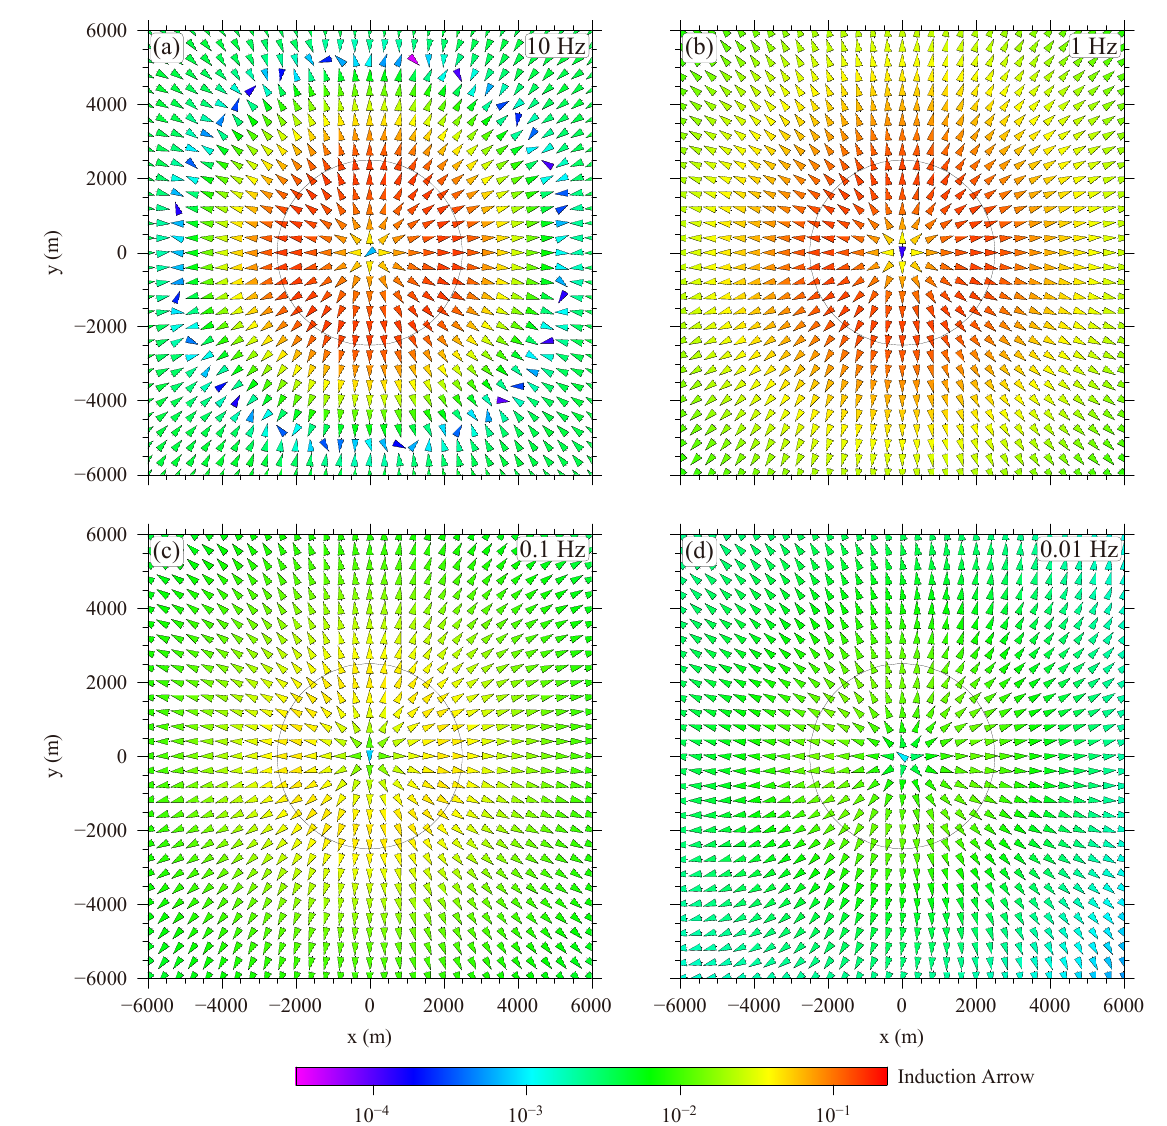
Figure 8. The vector maps of induction arrows for Model 1 of the typical hydrothermal system, as shown in Figure 5. ( a – d ) are for the frequencies of 10, 1, 0.1, and 0.01 Hz, respectively. The black circles indicate the projection of the clay cap on the x - y plane.